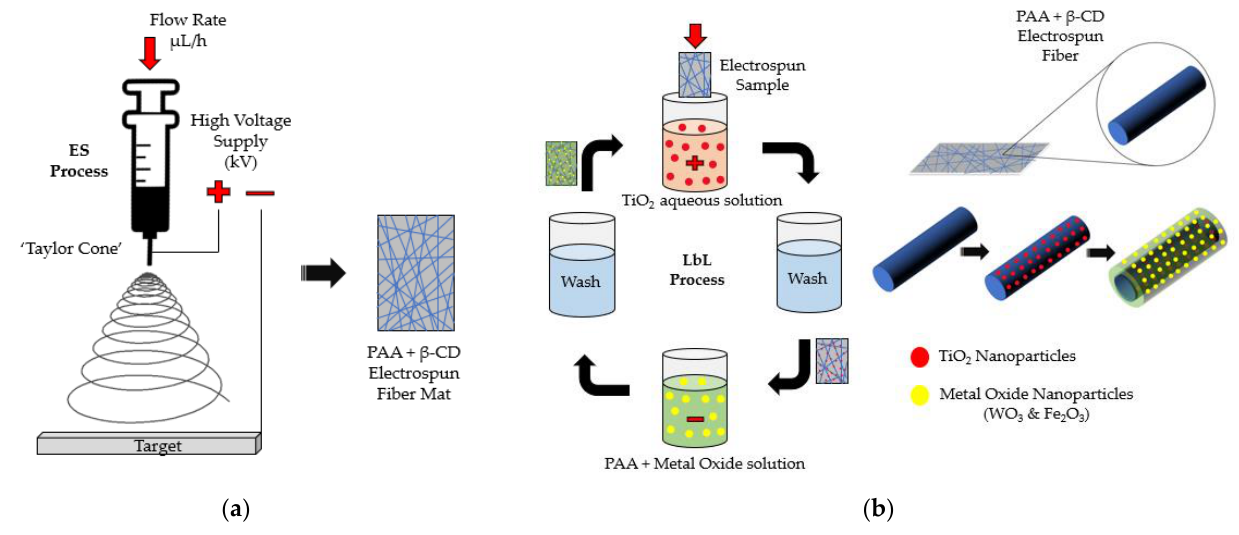
Figure 1. Schematic description of the fabrication of the thin films. ( a ) Electrospinning deposition technique; ( b ) Layer-by-layer assembly deposition technique.